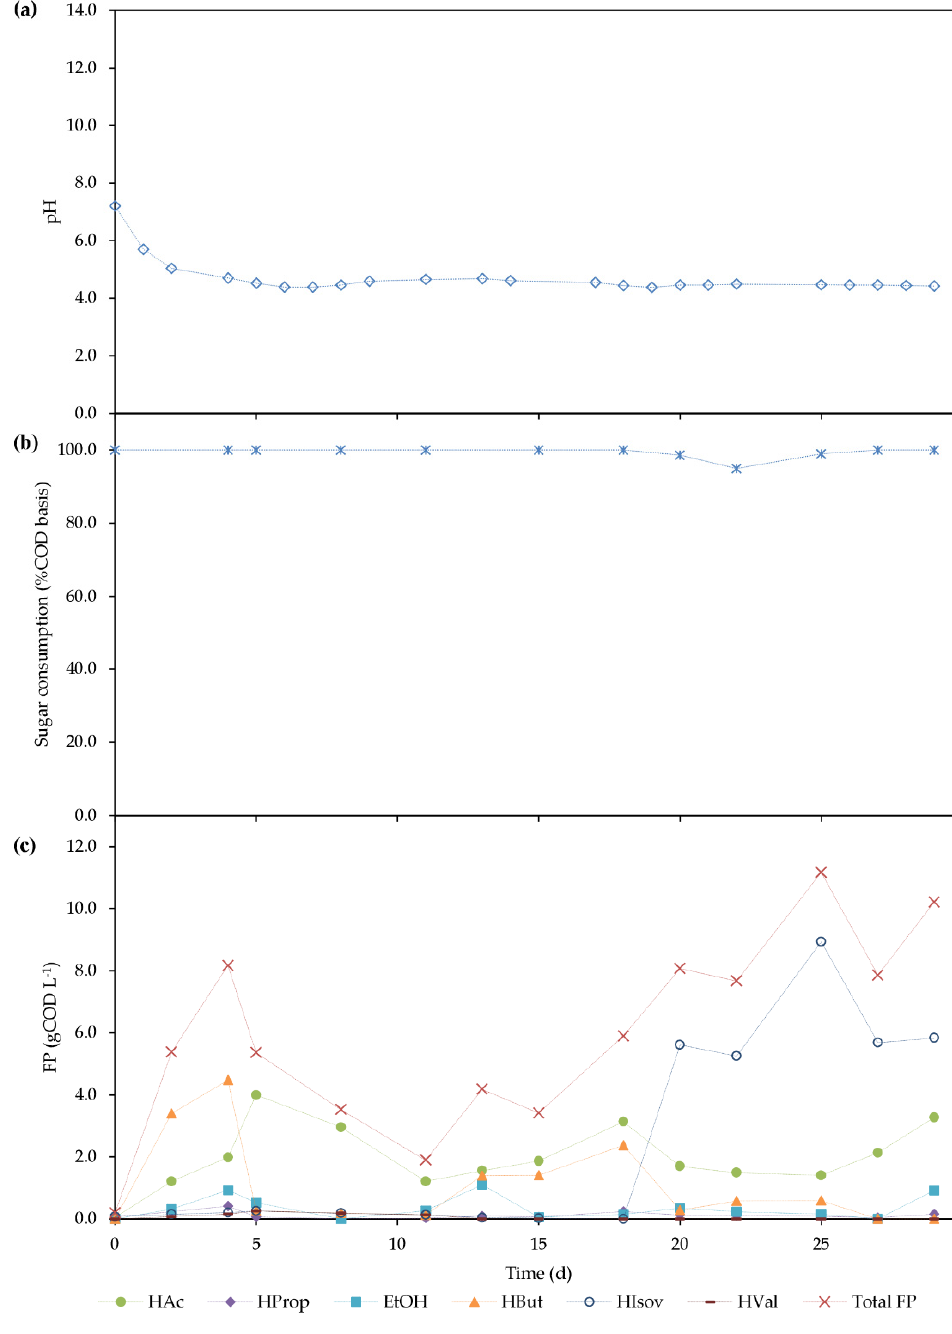
Figure 4. ( a ) pH variation, ( b ) Sugar consumption, and ( c ) Fermentation products (FP) produced during EGSB operation. Table 5. EGSB performance in the last 10 days of operation (between days 20 and 29 of operation).